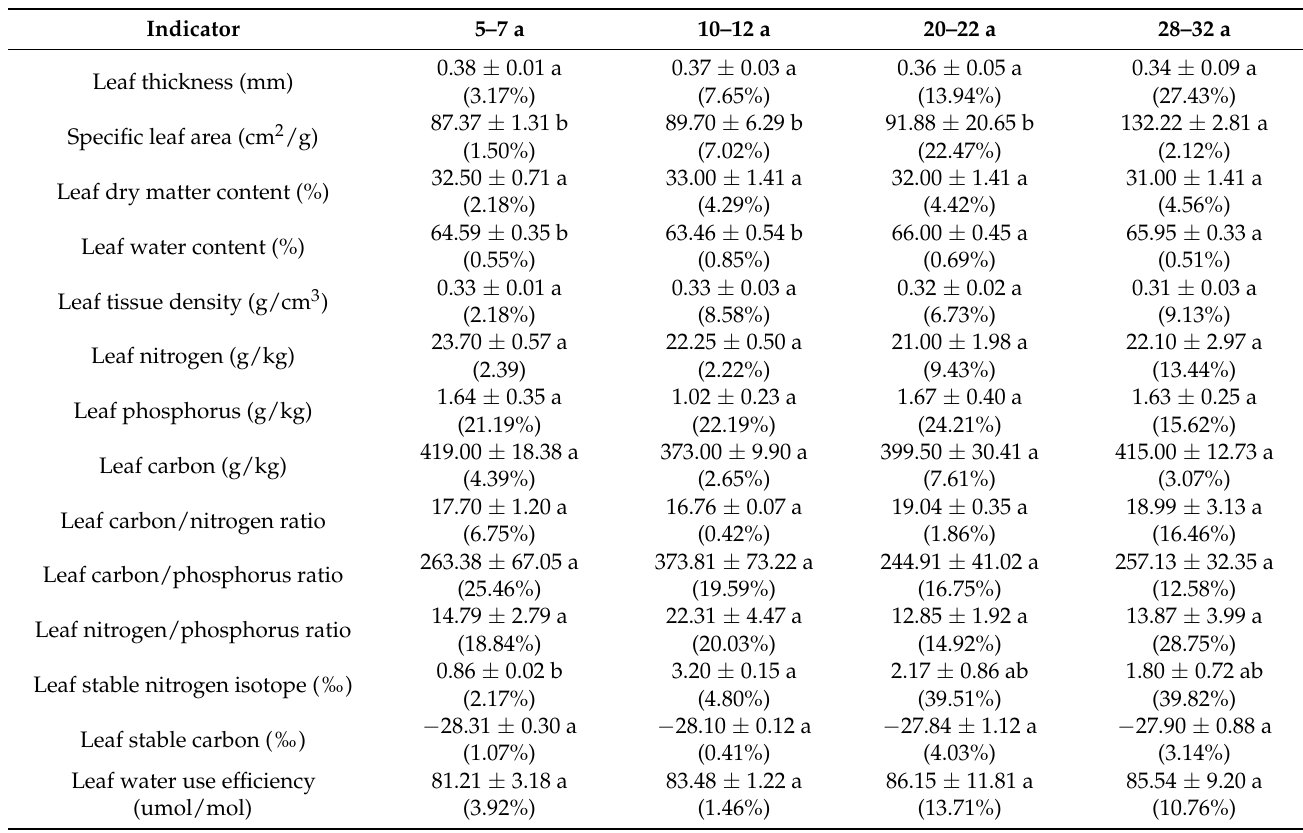
Table 3. Mean, standard deviation, and coefficient of variation of leaf functional traits of Z. planispinum ‘dintanensis’ at different plantation